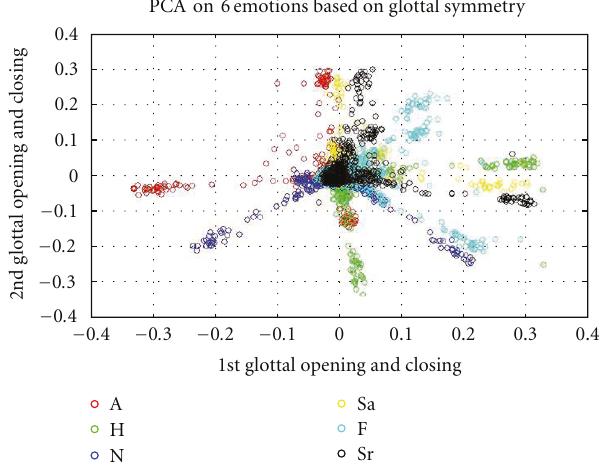
Figure 5: PCA analysis of the 1st versus 2nd Glottal Symmetry for 6